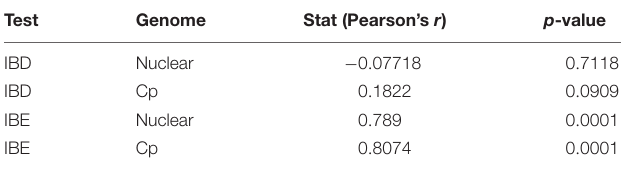
TABLE 2 | The results of Isolation by Distance (IBD) and Isolation by Environment (IBE) based on nuclear SSR and chloroplast (cp)